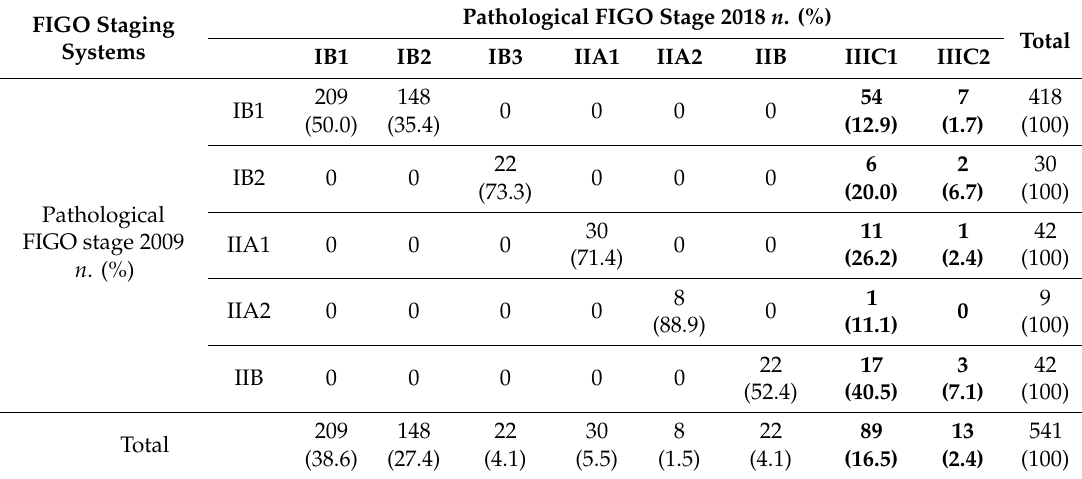
Table 2. Crosstab comparison of the distribution of patients according to the 2009 and the 2018 FIGO staging systems. Systems